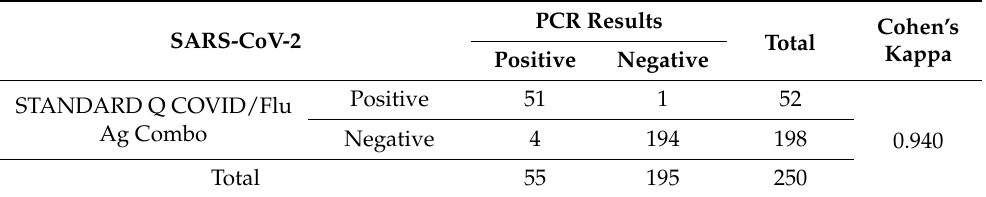
Table 1. Diagnostic performance of the STANDARD Q COVID/FLU Ag Combo compared to the real-time PCR for detection of SARS-CoV-2.